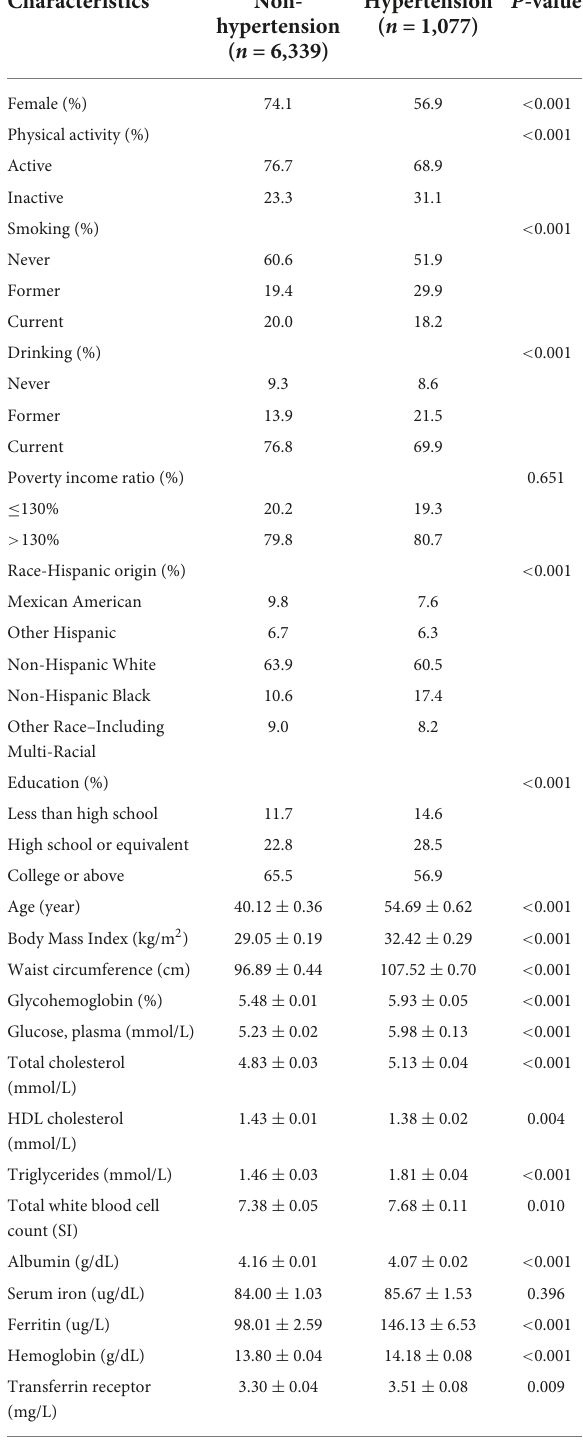
TABLE 1 Characteristics of the study population [National Health and Nutrition Examination Survey (NHANES) 2007–2010 and NHANES